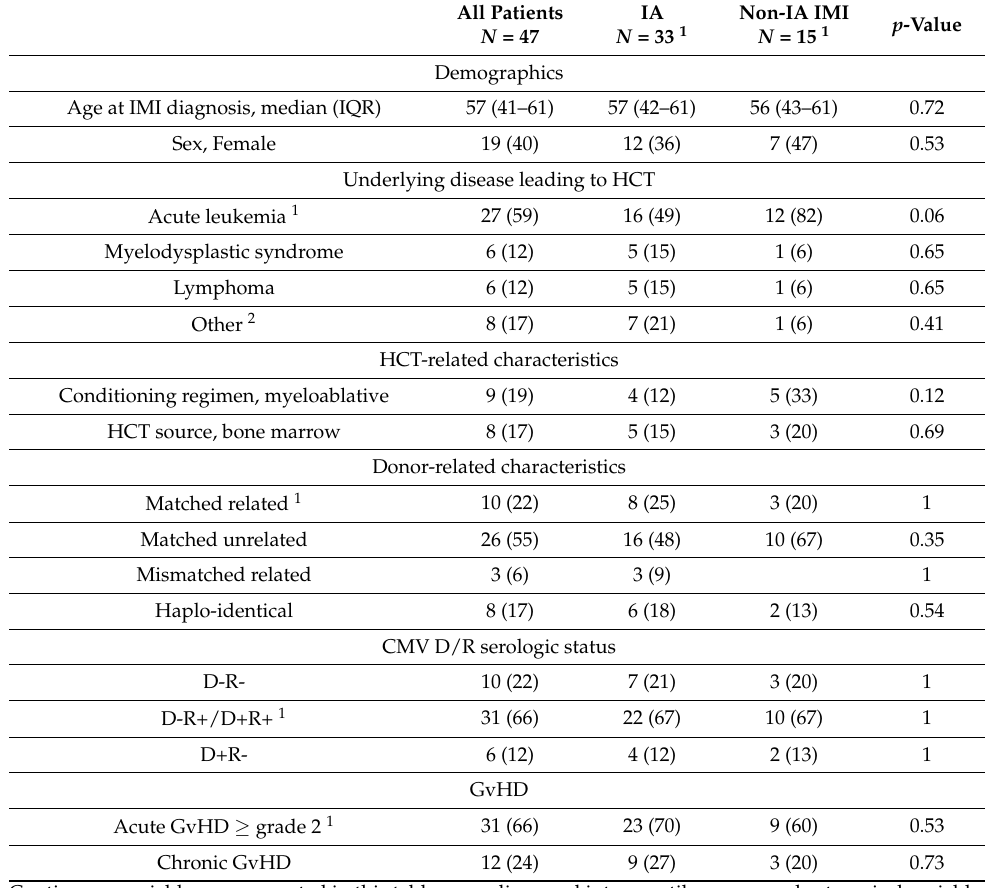
Table 1. Baseline characteristics of 47 allogeneic hematopoietic transplant recipients diagnosed with 48 invasive mold